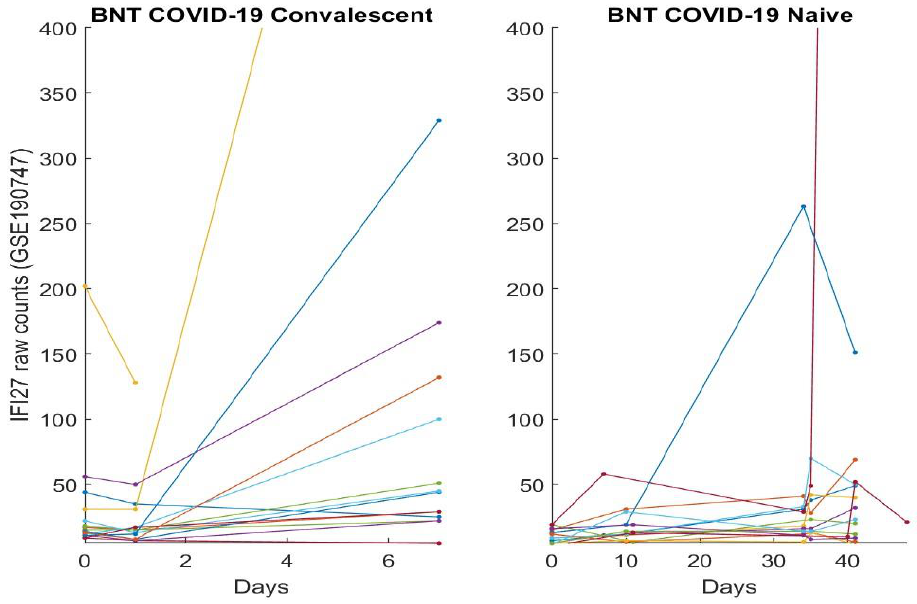
Figure 7. IFI27 expression responses to BNT162b2 vaccines: The left panel is for COVID-19-recov- ered octogenarians; the right panel is for COVID-19-naïve individuals. Each color line corresponds to one patient’s records.